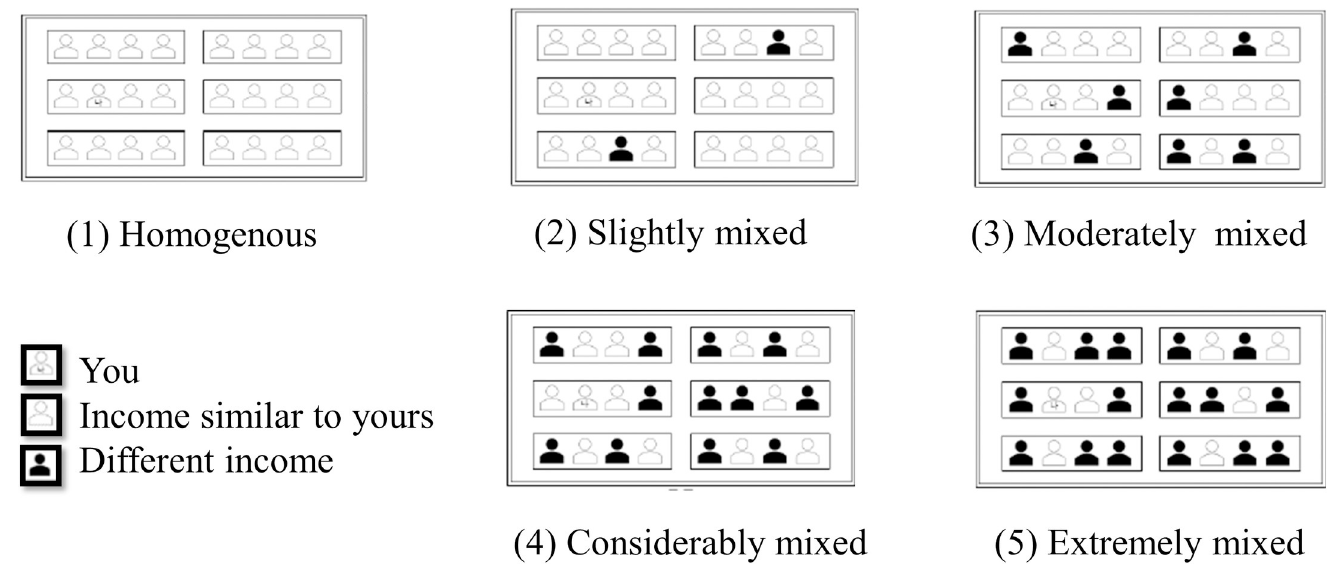
Fig 1. Descriptions of five different mixed-income